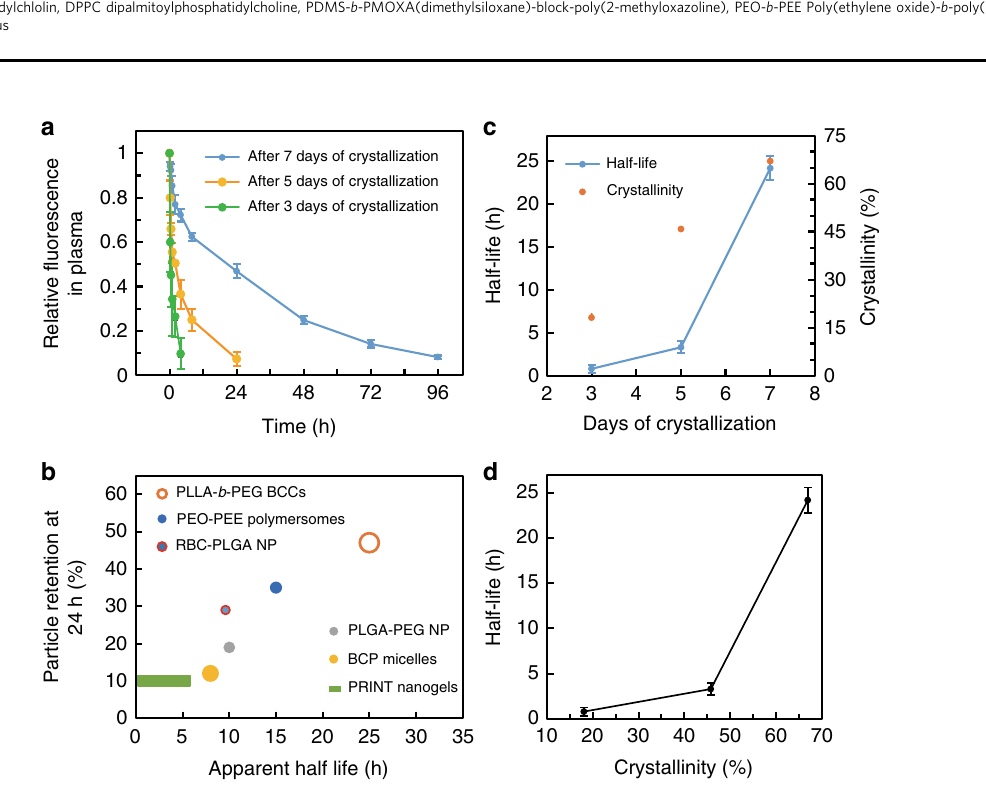
Fig. 5 Dependence of BCC blood circulation on their crystallinity. a In vivo circulation of DiD-loaded BCCs crystallized for different times. b In vivo circulation performance among representative polymeric nanoparticles (PEO- b -PEE polymersomes 47 , RBC-PLGA NP 6 , surface-modi fi ed PLGA-PEG NP 44 , BCP micelles 56 , and PRINT nanogels 30 ) with long blood circulation. A plot of relative intensities at 24 h vs. apparent half-lives, where relative symbol sizes represent relative hydrodynamic sizes/shapes and data are taken from the respective references. c BCC crystallinity and half-life variation with different crystallization times. d The correlation of circulation half-life and crystallinity of BCCs. Error bars in a , c represent mean ± s.d, n = 3 – 5